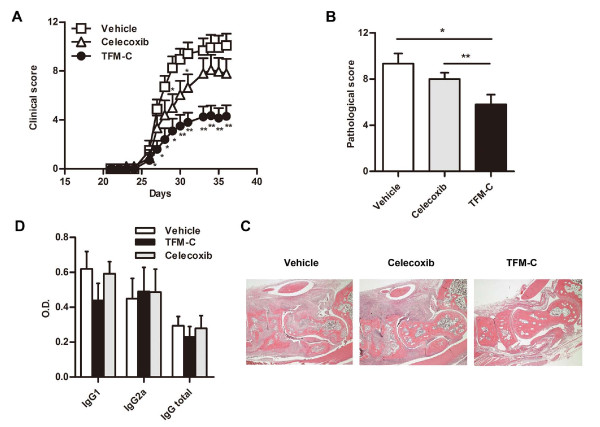
The effect of TFM-C on CIA. A. Clinical scores of CIA in DBA1/J mice treated with 10 μg/g TFM-C (closed circles), celecoxib (open triangles) or vehicle (open squares) every other day from 21 days after immunization. The data shown are pooled from two similar experiments. Error bars represent + SEM of 10 to 12 mice per group. * P < 0.05 compared with control group. * P < 0.05 compared with both control and celecoxib-treated groups. B. Quantification of histological assessment of joints 37 days after induction of CIA. Result shown is the mean + SEM of five mice per group. * P < 0.05, TFM-C-treated versus vehicle-treated group. * P < 0.05, celecoxib-treated versus TFM-C-treated group. C. Representative histological feature of joints in vehicle-treated (left), TFM-C-treated (right) and celecoxib-treated (middle) mice. (H&E stained; original magnification × 40). D. The effect of TFM-C on CII-specific response. CII-specific antibody responses in vehicle- (open bars), TFM-C- (filled bars) and celecoxib-treated (gray bars) group. Individual serum samples were obtained at Day 37 after the induction of arthritis and were analyzed as indicated in Materials and Methods. Data represent the mean + SEM of five mice per group.